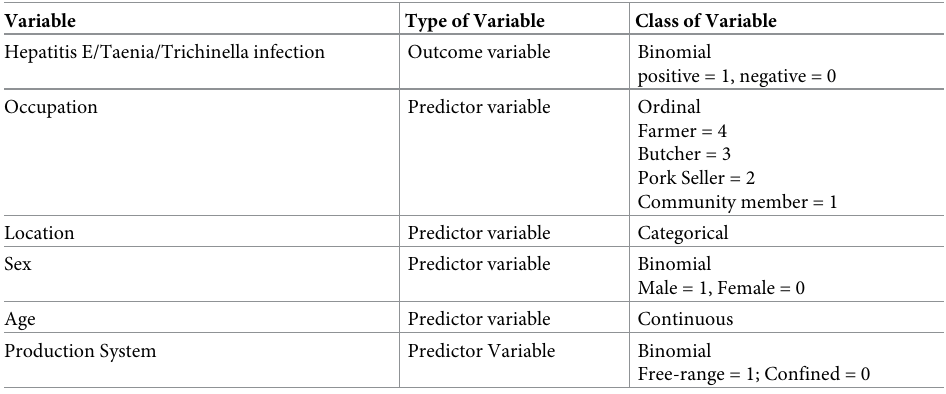
Table 4. Logistic regression